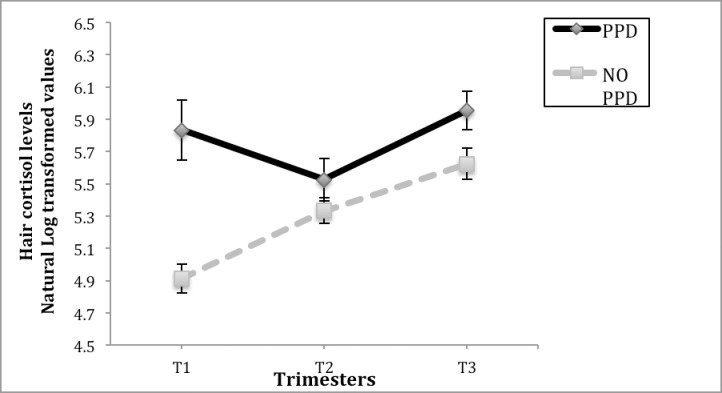
Hair cortisol levels differences (pg/mg) in each trimester between women with and without postpartum depression symptoms.
Note. *Significant at the p ≤ .05 level.